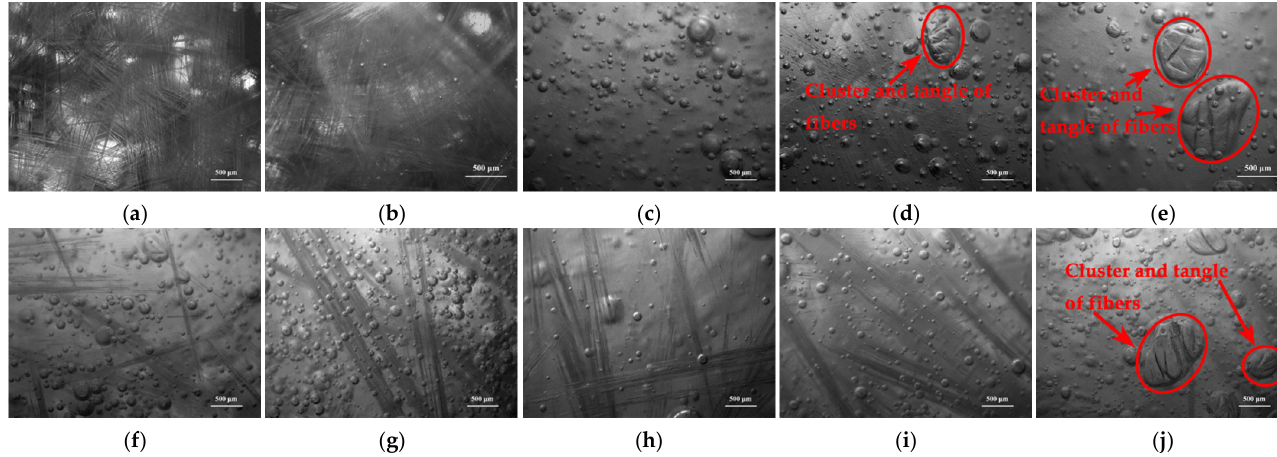
Figure 4. Micrographs of distributions of 15.0 mm chopped glass fibers in resin glue: ( a ) in the presence of 10.00 phr, ( b ) in the presence of 15.00 phr, ( c ) in the presence of 20.00 phr, ( d ) in the presence of 25.00 phr, ( e ) in the presence of 30.00 phr got from type ER2400-T628, ( f ) in the presence of 10.00 phr, ( g ) in the presence of 15.00 phr, ( h ) in the presence of 20.00 phr, ( i ) in the presence of 25.00 phr, ( j ) in the presence of 30.00 phr got from type ER4800-T718.